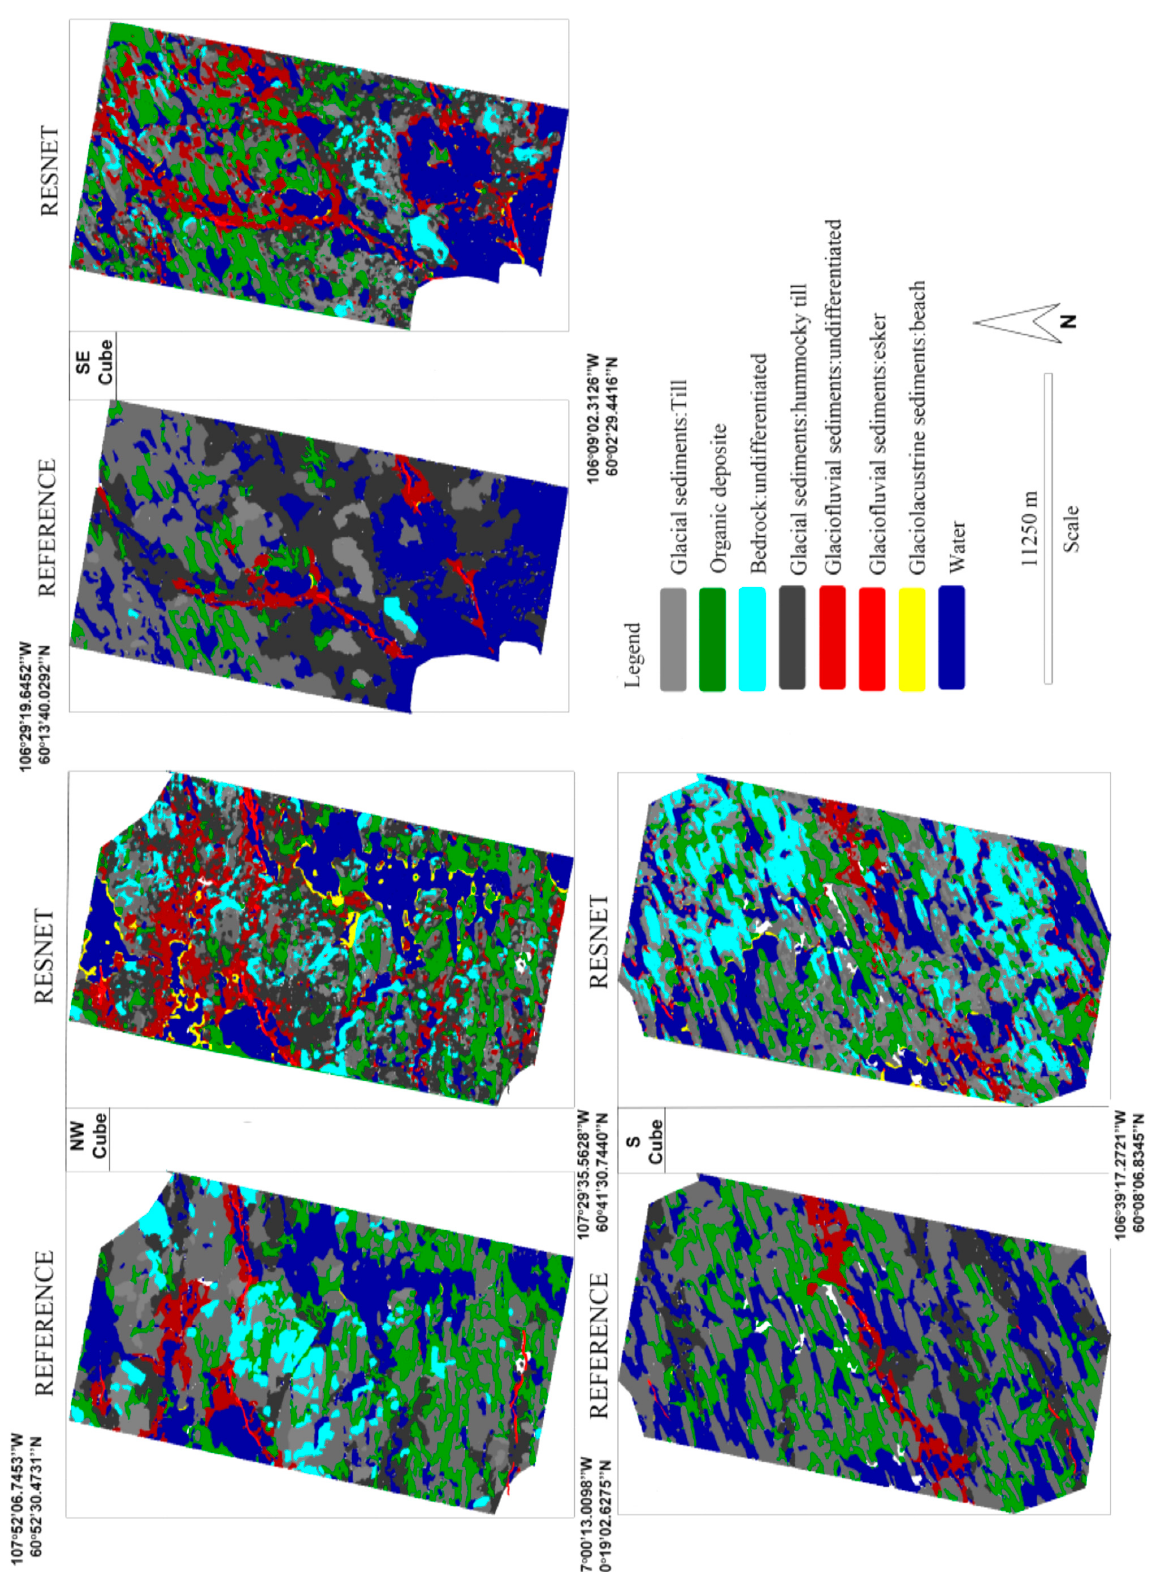
Figure 10. RESNET classification results for Northwest, South and Southeast subareas.